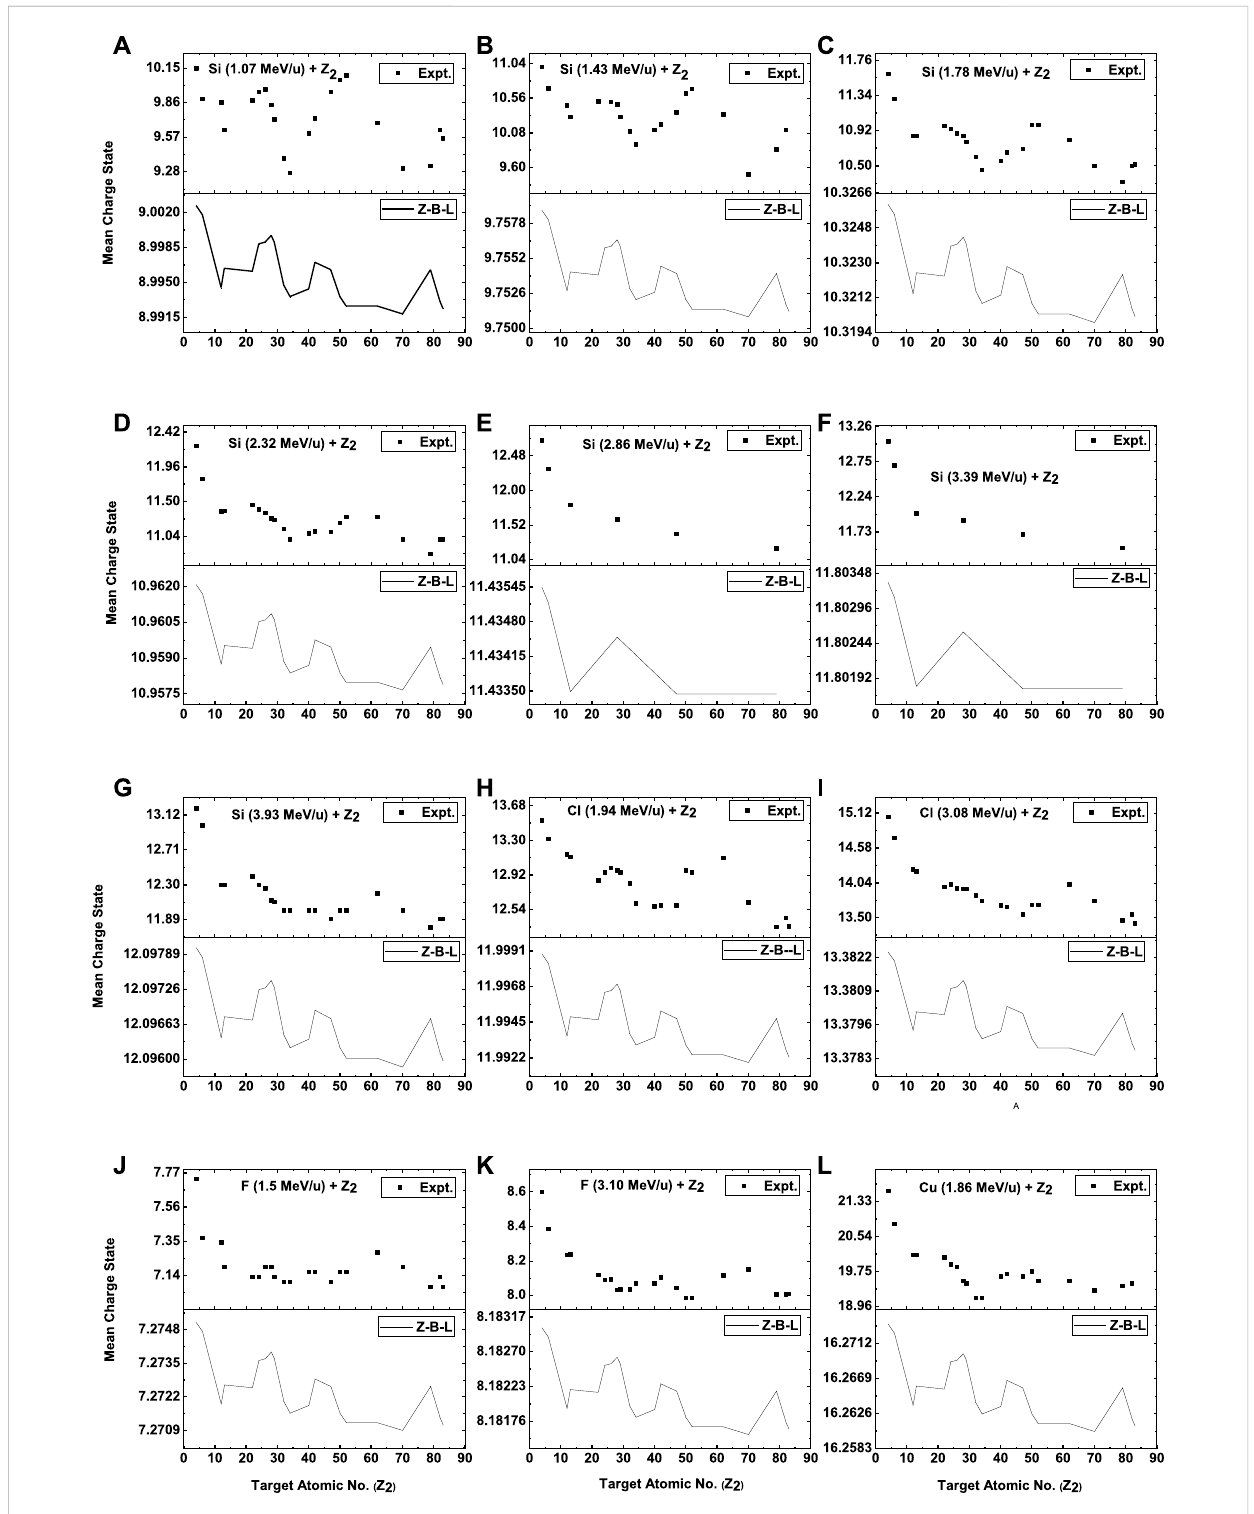
FIGURE 2 Comparison of experimental mean charge state (cid:1) q [26] with Z-B-L mean charge state at different energies as a function of target atomic number (A-L) . The solid lines are to guide the eye only.